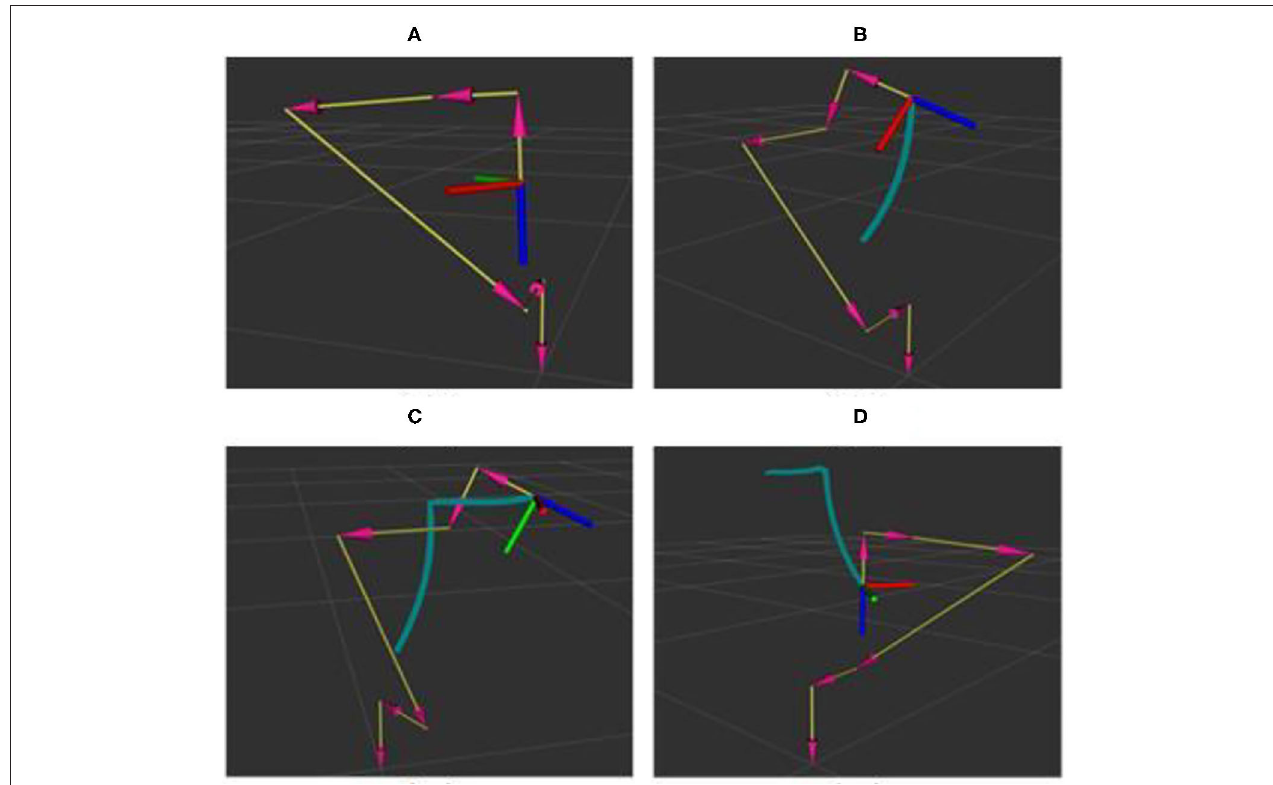
FIGURE 13 | Desired trajectory of the robot in the assembly task. (A–D) Presents the trajectories of robot starting, photographing, assembling and returning to the starting point